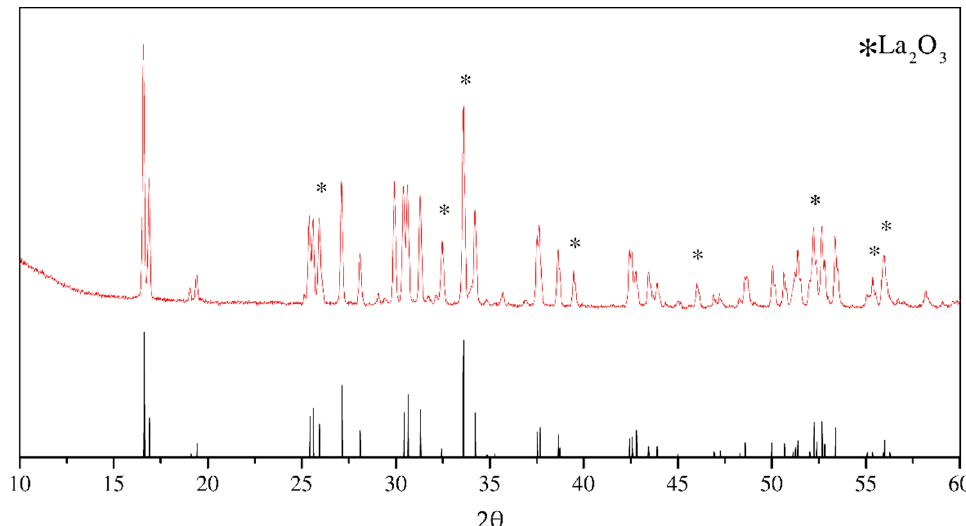
Figure 1. X-ray diffraction pattern of the synthesized tetragonal Li 7 La 3 Zr 2 O 12 by solid-state reaction. Bottom vertical lines belong to PDF #00-064-0140.